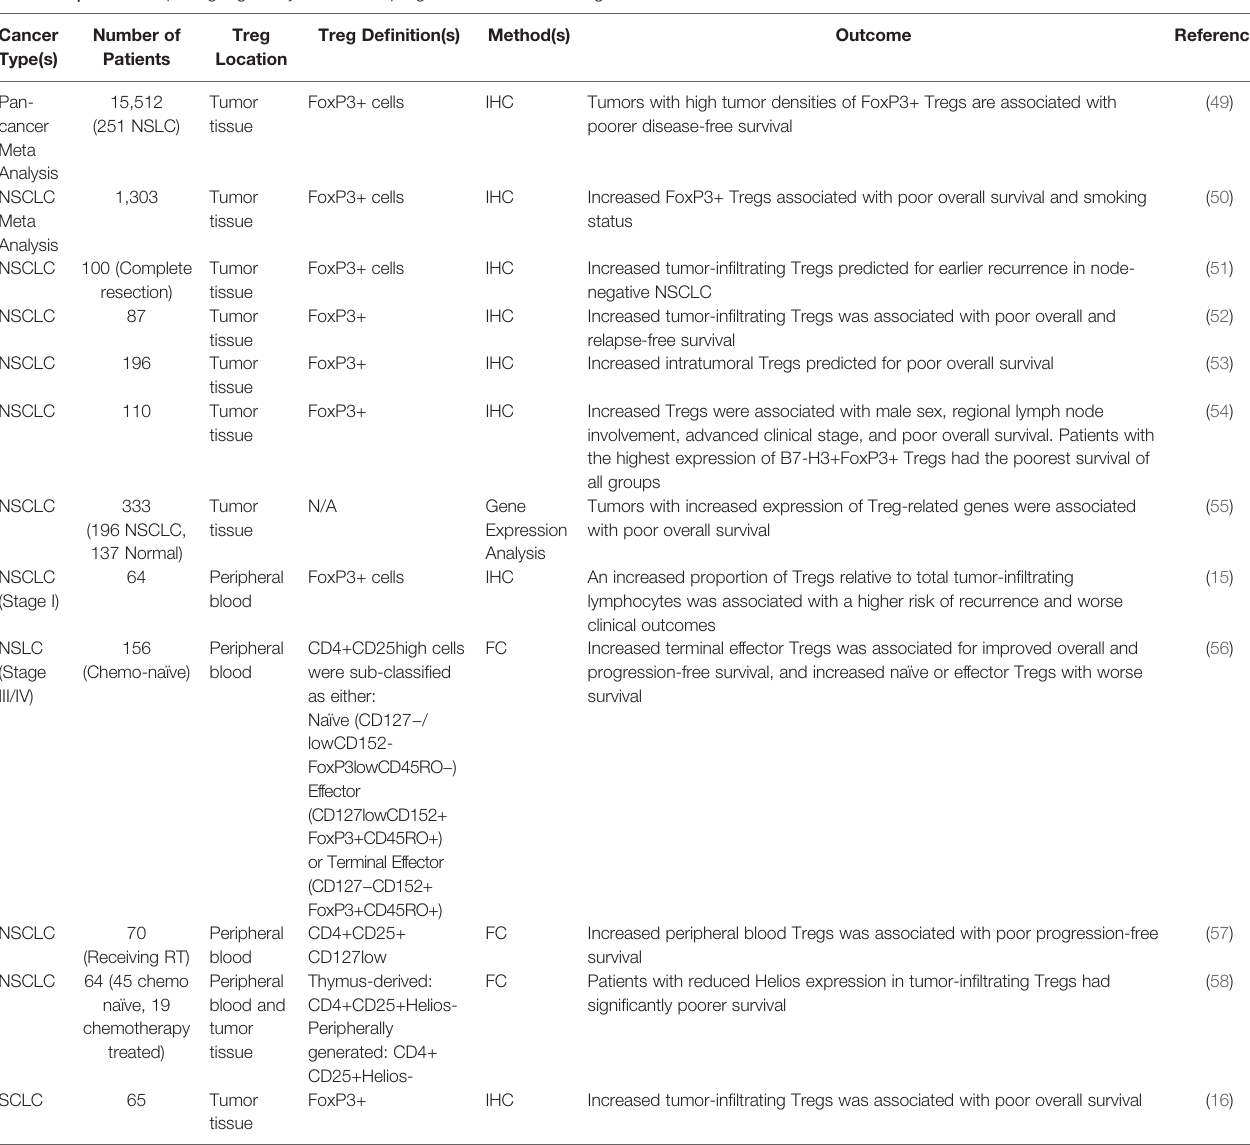
TABLE 1 | Studies exploring regulatory T cells as a prognostic biomarker in lung